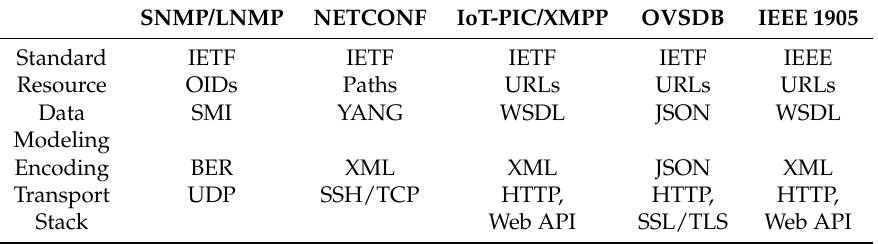
Table 5. Main characteristics comparison of the IoT Network Management